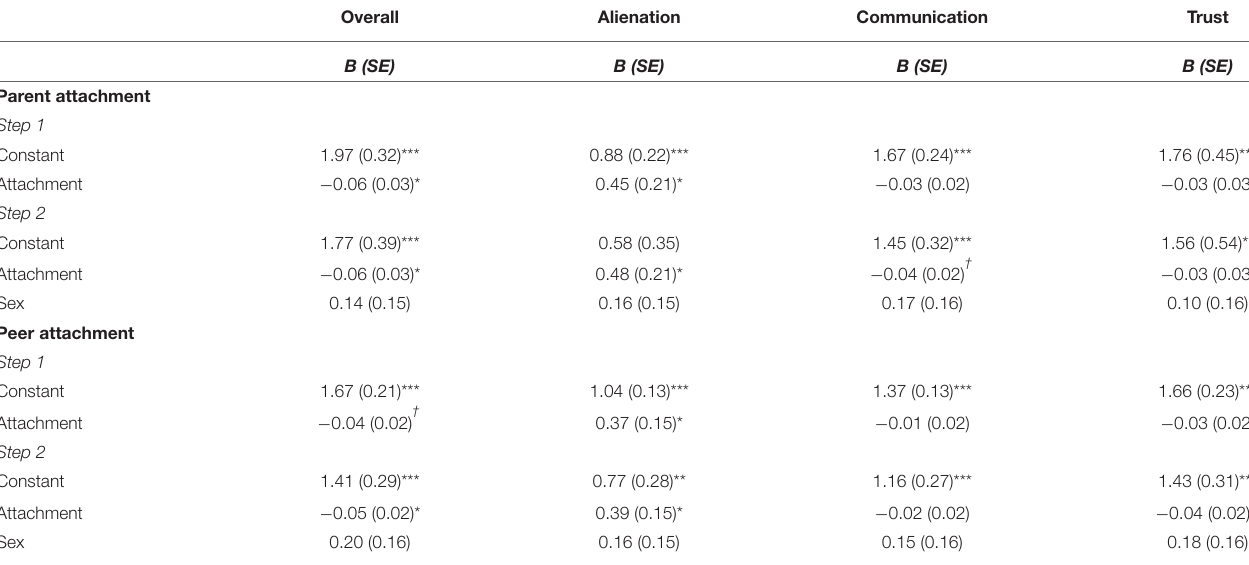
TABLE 2 | Regression analyses of parent and peer attachment scales on the intercept parameters of mood variability. Overall Alienation